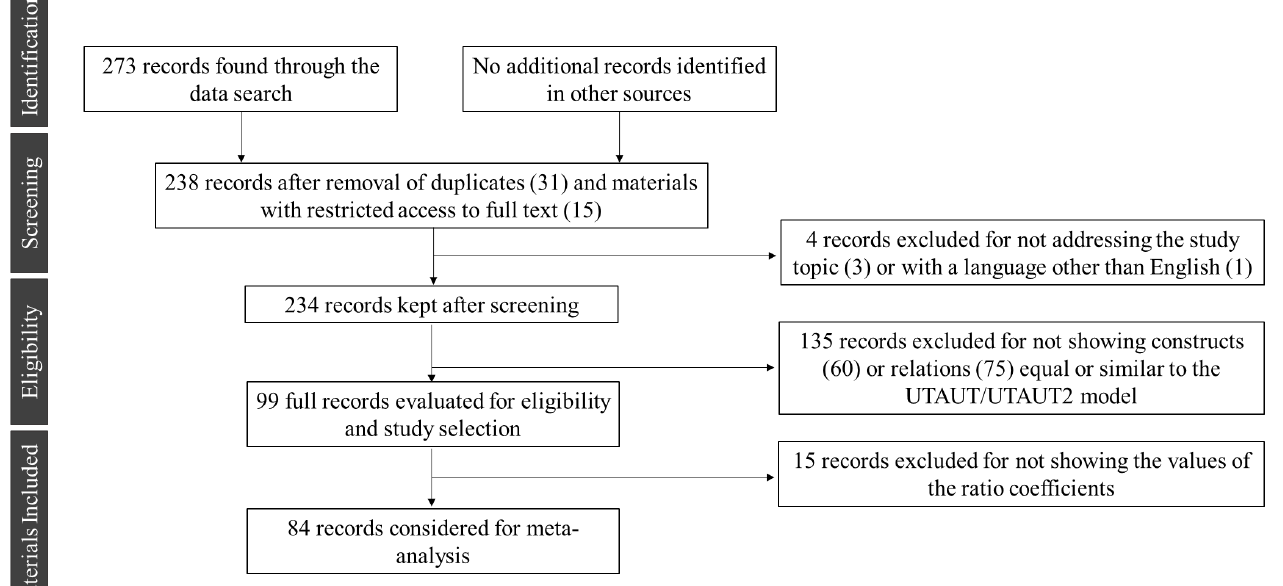
Figure 2. Details of the filtering mechanism of the materials selected for the meta-analysis.